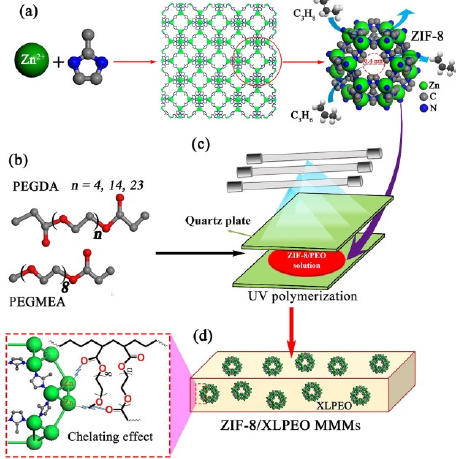
Figure 13. Illustration of fabrication for ZIF-8 / XLPEO MMMs: ( a ) ZIF-8 framework synthesised from zinc ion and 2-methylimidazole, ( b ) highly adjustable gas-permeability of XLPEO matrices derived PEGDA and PEGMEA pre-polymers with various molar ratios. ( c ) Formation process of ZIF-8 / XLPEO MMMs through the one-step UV polymerisation and ( d ) schematic illustration for interfacial interaction between ZIF-8 fillers and XLPEO matrices in the resulting MMMs. Reprinted with permission from [101], Copyright (2019)